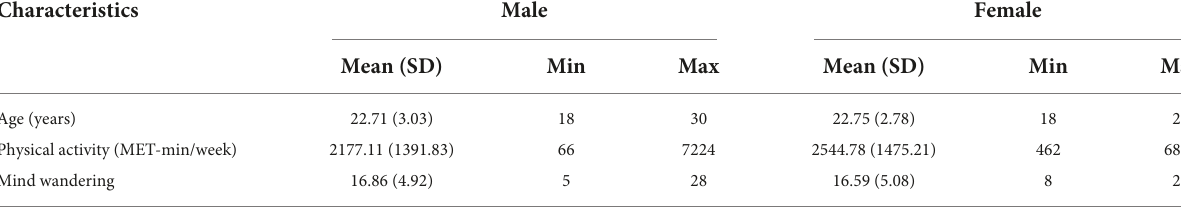
TABLE 1 Characteristics for participants who contributed both fMRI and questionnaires data. Characteristics